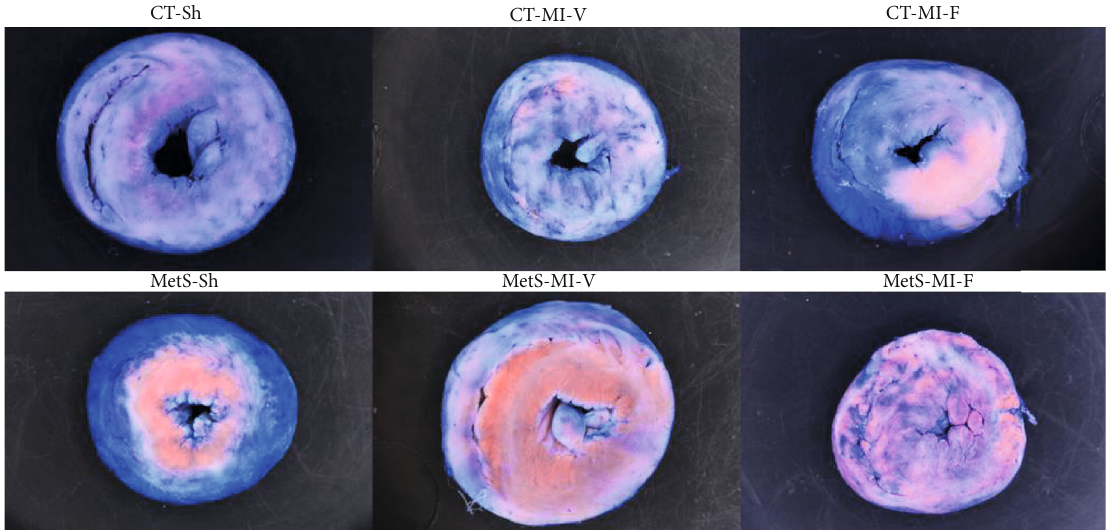
Figure 7: Feno fi brate treatment decreased the area at risk in myocardial infarcted rats. Representative images of TTC staining. Blue areas indicate viable tissue; the red-colored region represents tissue at risk, and the white regions indicate the infarcted myocardium. CT-Sh and MetS-Sh: control and metabolic syndrome sham-operated groups; CT-MI-V: control myocardial infarction vehicle-treated; CT-MI-F: control myocardial infarction feno fi brate-treated; MetS-MI-V: metabolic syndrome myocardial infarction vehicle-treated; MetS-MI-F: metabolic syndrome myocardial infarction feno fi